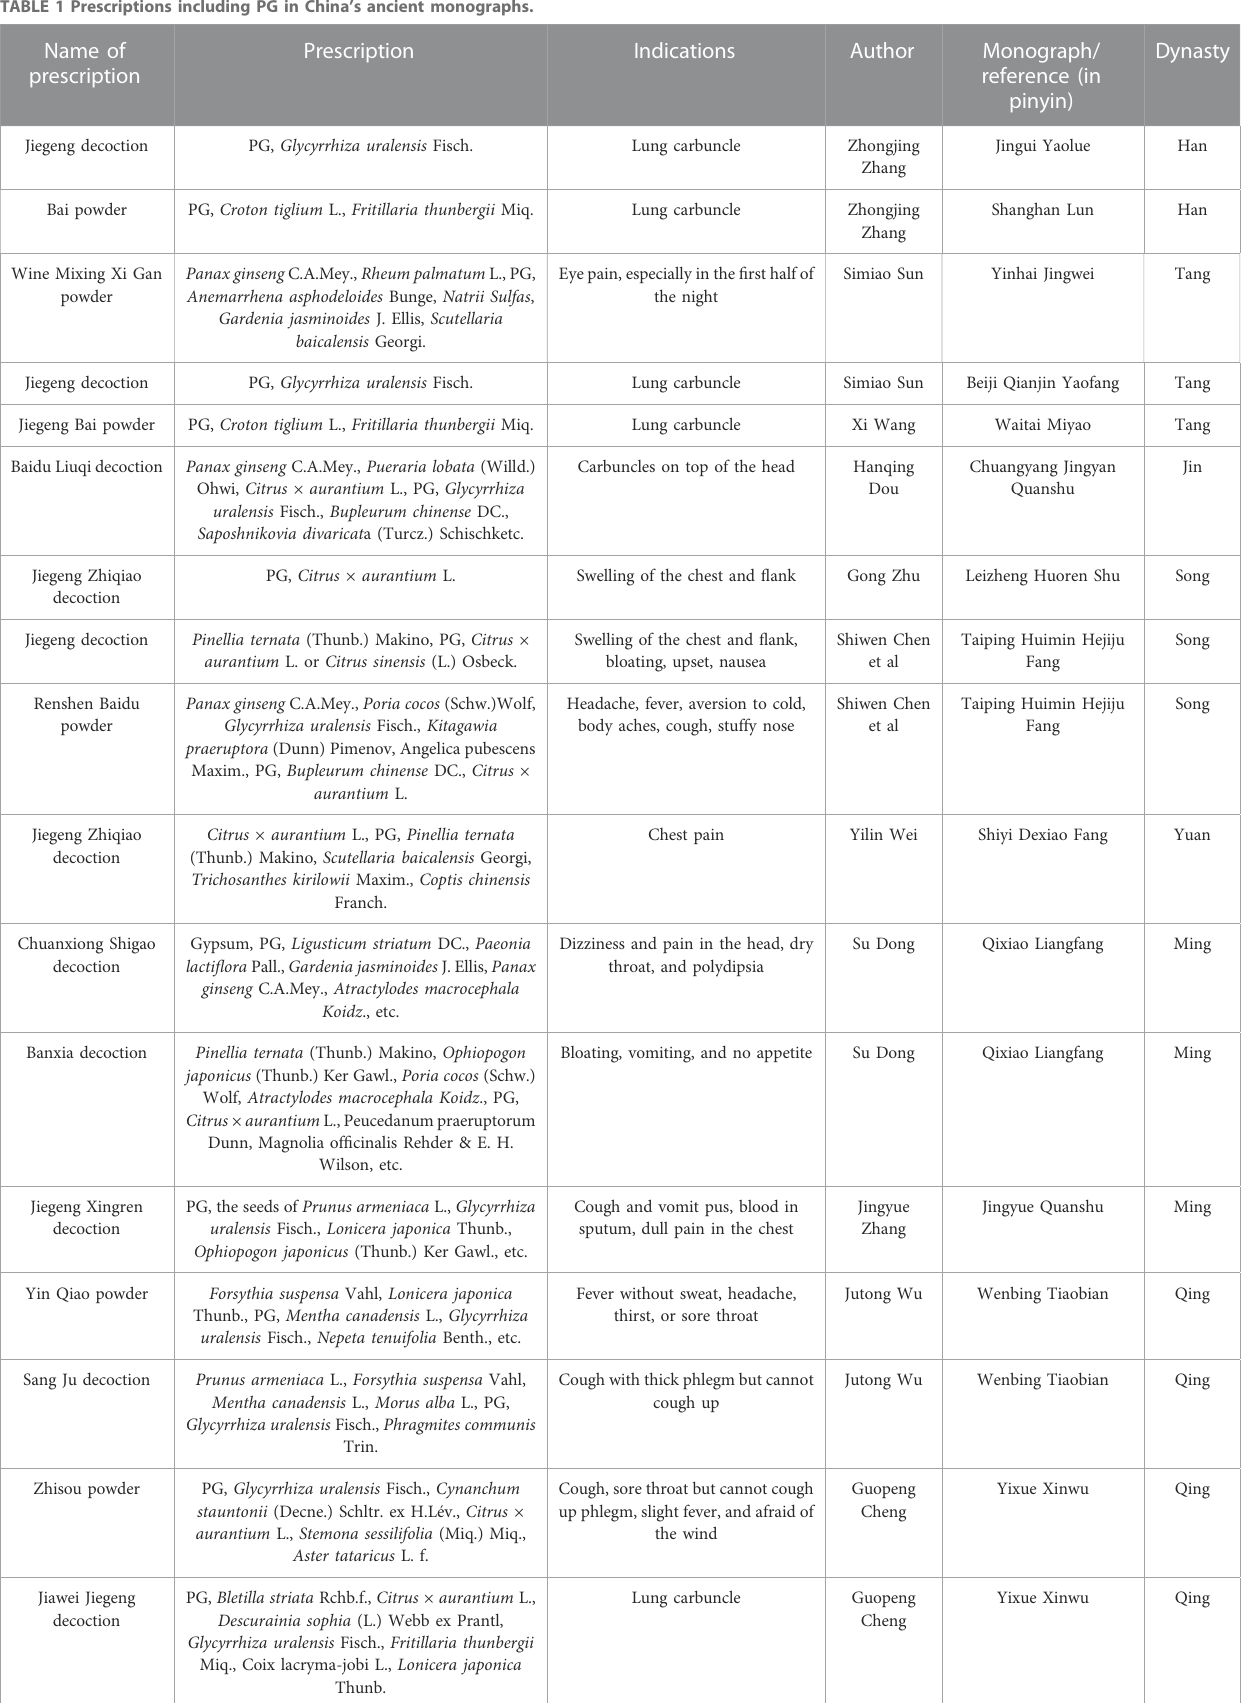
TABLE 1 Prescriptions including PG in China ’ s ancient